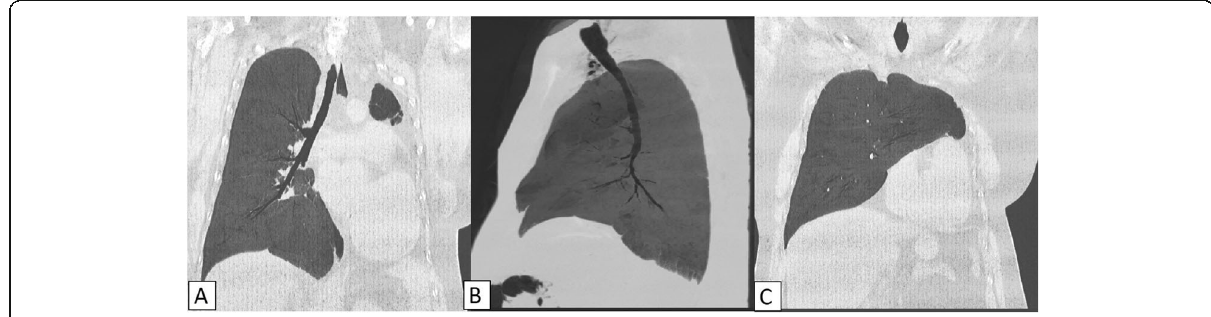
Fig. 4 Minimum intensity projection CT images in coronal and sagittal planes show solitary right bronchus and lung ( A , B ). Mild tracheal narrowing is seen in its upper intrathoracic part ( B ). There is herniation of hypertrophied right lung across the midline into the left upper hemithorax ( C )